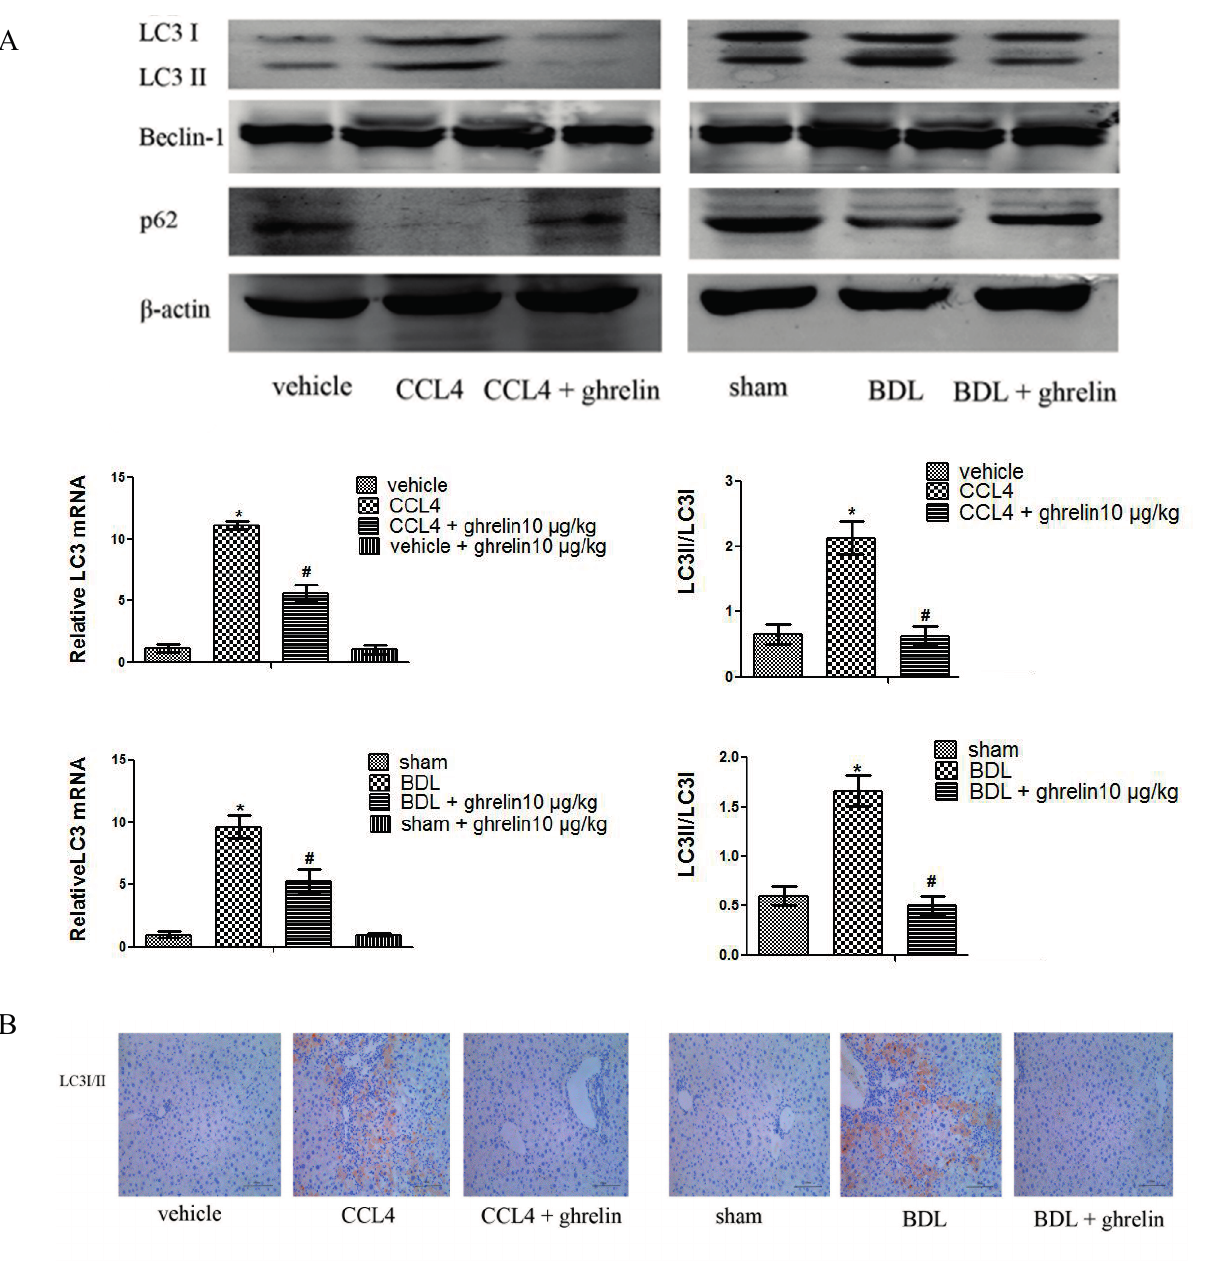
Figure 7. Ghrelin inhibited the process of autophagy in liver fibrosis. ( A ) Western blot analyses of LC3I/II, Beclin-1 and p62 in both the CCl 4 - and BDL-induced fibrotic liver tissues. Real-time PCR shows gene expression of LC3 ( n = 7, * p < 0.05 for the CCl 4 or BDL group vs. the vehicle or sham group, # p < 0.05 for the ghrelin + CCl 4 or BDL group vs. the CCl 4 or BDL group); and ( B ) Immunohistochemical staining (200×) of LC3I/II in the CCl 4 - and BDL-induced fibrotic liver tissues. The scale bar of each figure is 200 μ m, and the magnification is